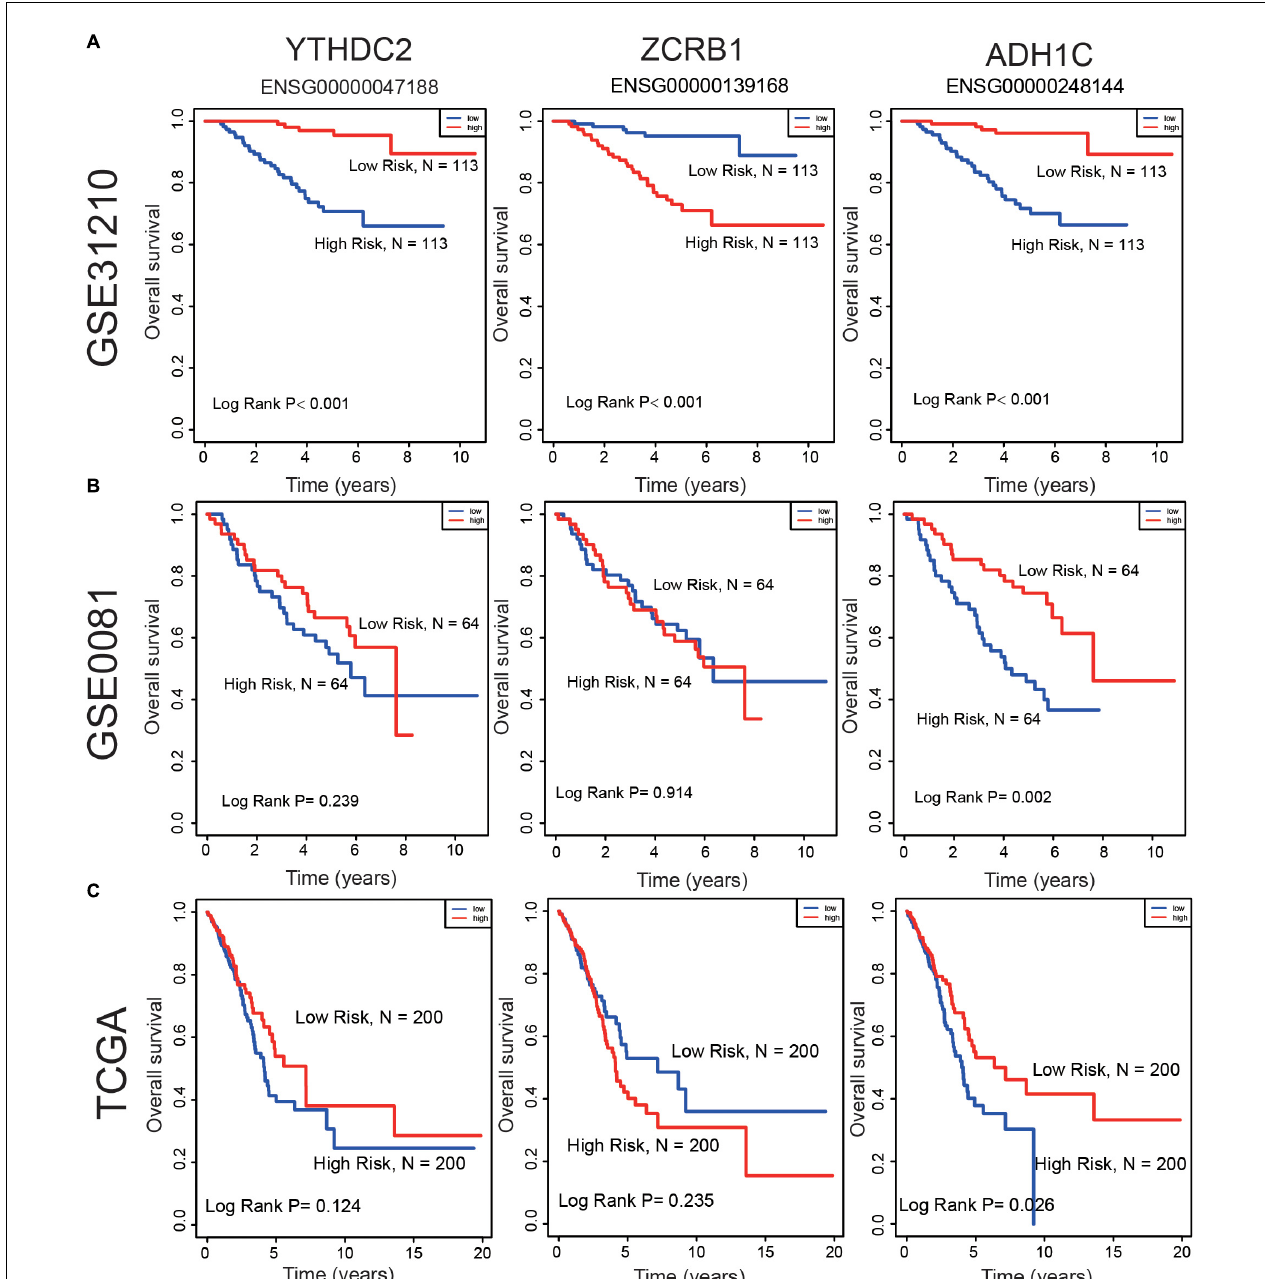
FIGURE 7 | Compare the low and high expression of the three predictive genes in overall survival in (A) GSE31210 dataset, (B) GSE50081 dataset, and (C) TCGA